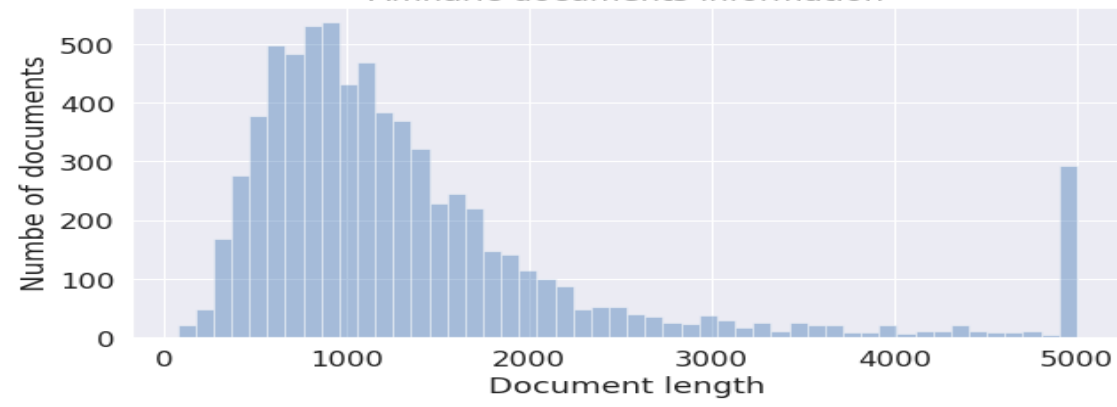
ple, given the sentence “ ጽሁፍ የተጻፈው የህክምና እርዳታ ለመስጠት አይደለም / ts ʼɨ huf ɨ j ə t ə ts ʼ af ə w ɨ